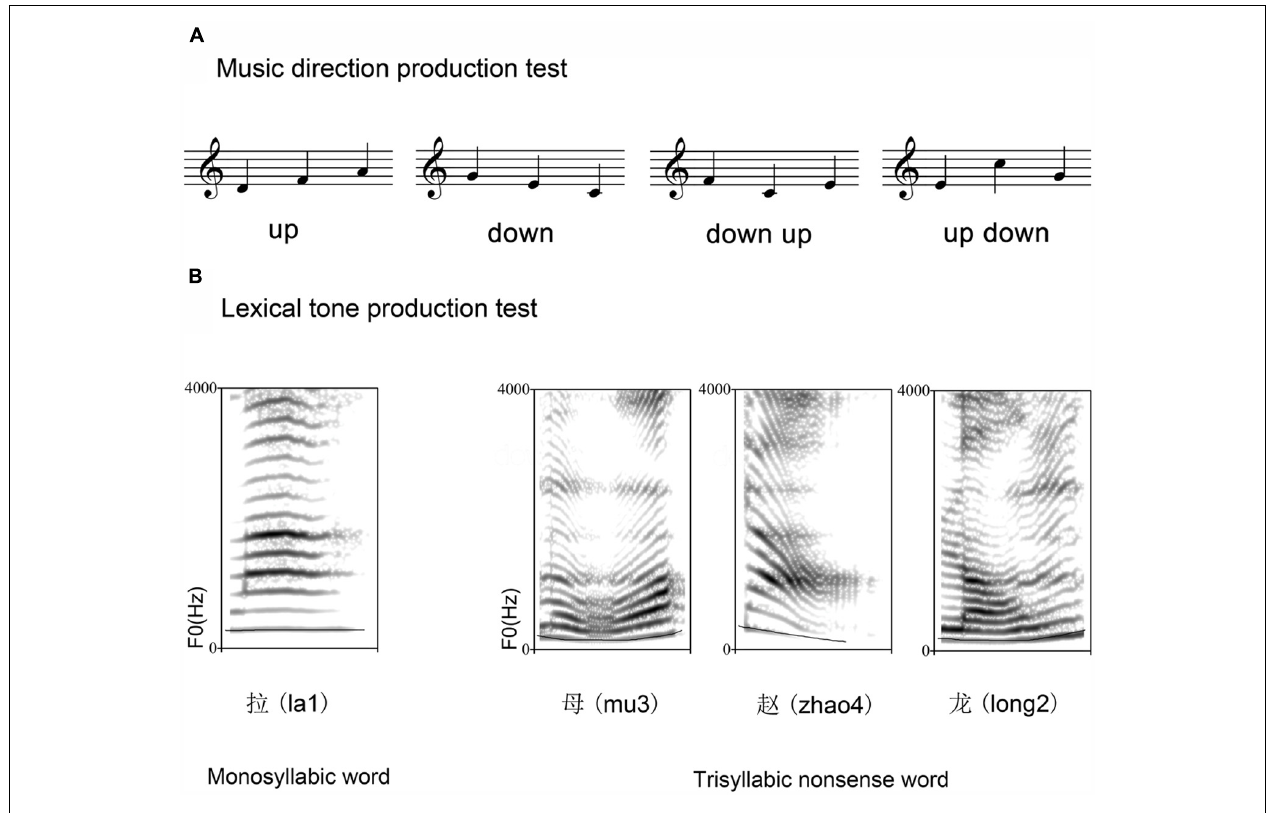
FIGURE 1 |The exemplar stimuli used in the music three-note imitation test (A) and lexical tone production test (B) .